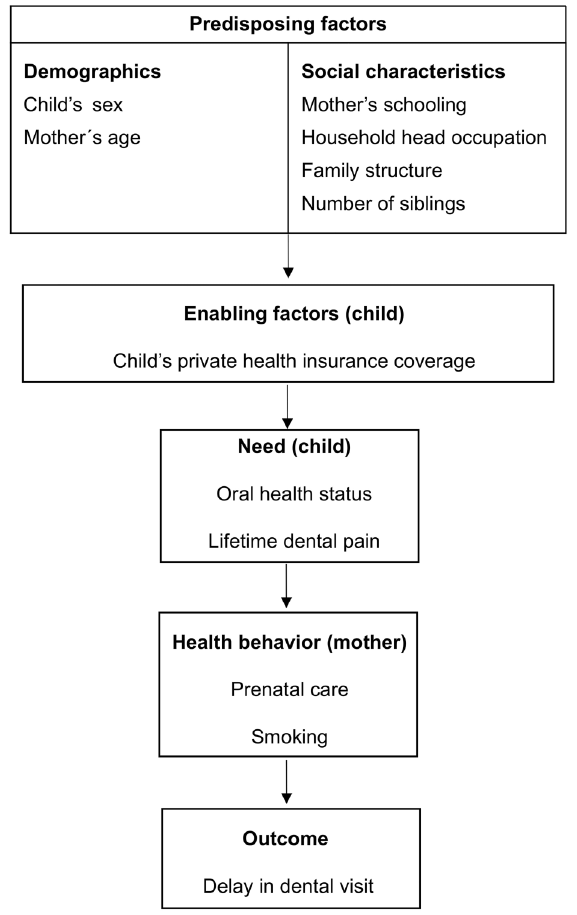
Figure 1. Theoretical model based on the Andersen, Davidson, and Baumeister behavior model of health services utilization (23)